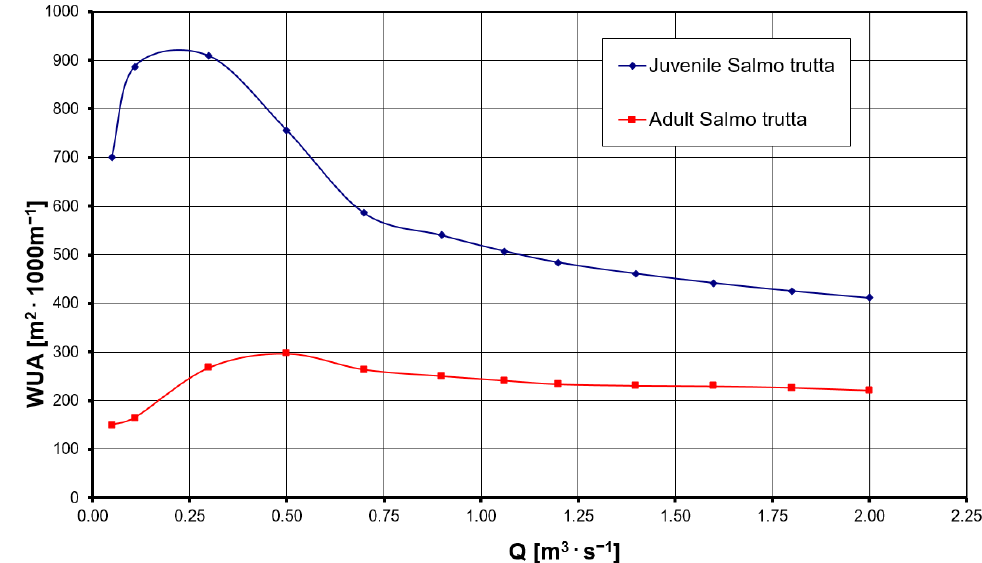
Figure 6. An example of the relationship between Weighted Usable Area (WUA) and flow for Adult Salmo trutta and Juvenile Salmo trutta. The optimal minimum flow is found on the highest point of the curve, 0.24 m 3 × s − 1 for juvenile and 0.5 m 3 × s − 1 for adult Salmo